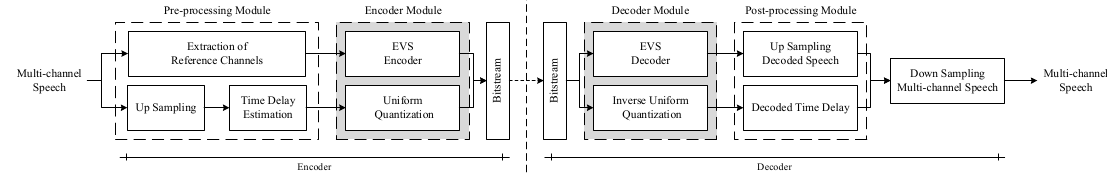
Figure 11. Block diagram of the up-sampling (US)-Multi-EVS-TDOA.